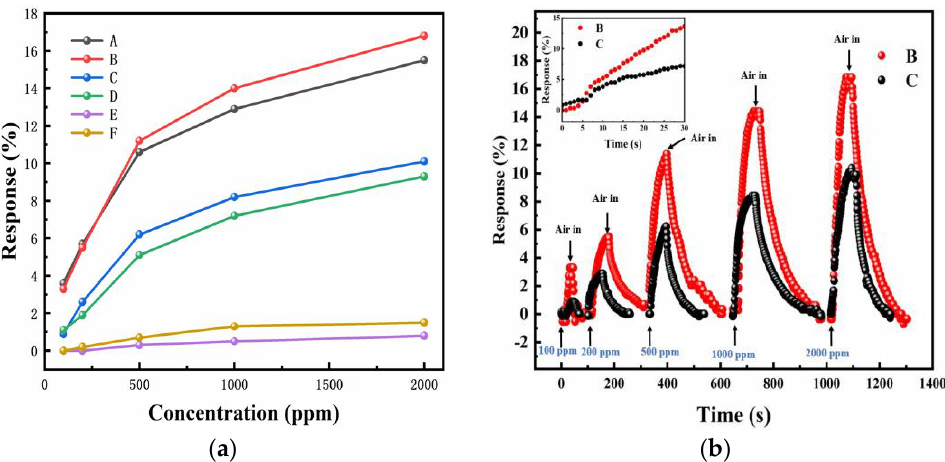
Figure 6. Resistance variation as a function of hydrogen concentrations for Mg-doped InN sensors at 125 °C at different Mg cell temperatures. ( a ) The response of all samples as a function of gas atmosphere. ( b ) The response curve of sample B and C. The inset shows their transient response in first 30 s upon exposure to 2000 ppm H 2 /air, almost linear with respect to time.